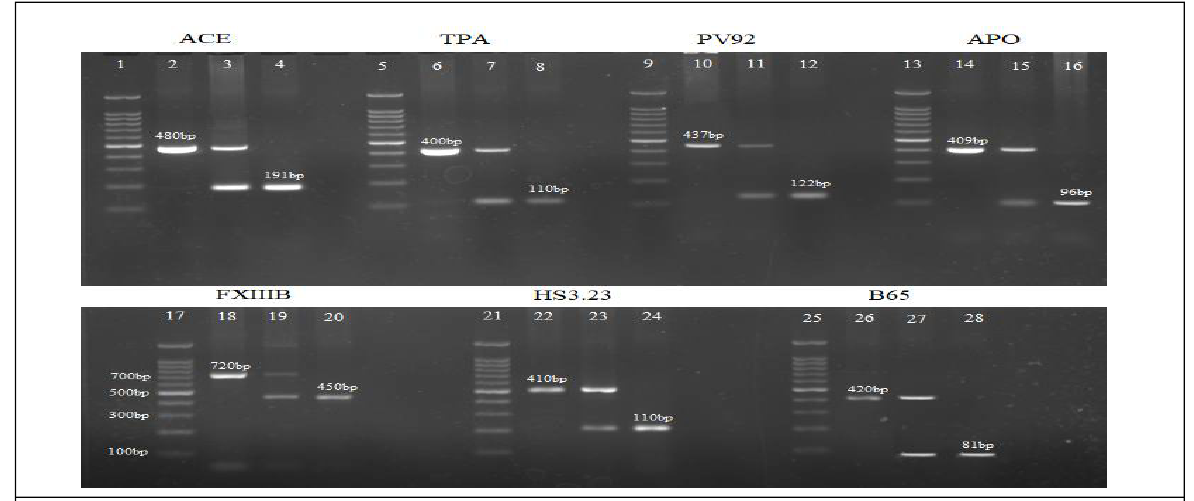
Figure 1: Representative PCR amplification products of the seven Alu DNA genetic loci from unrelated Jordanian blood